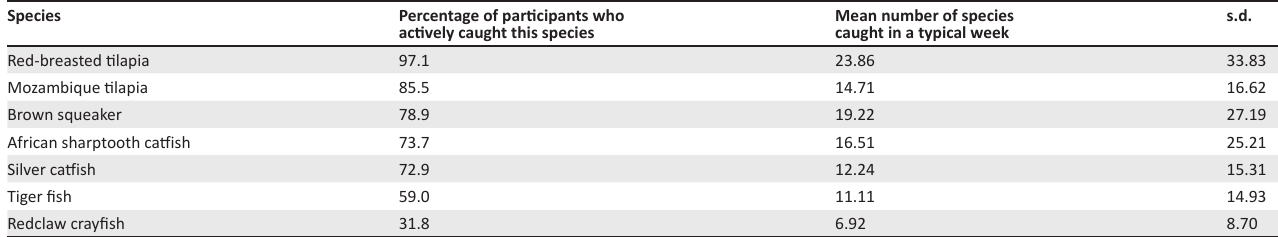
s.d., standard deviation.